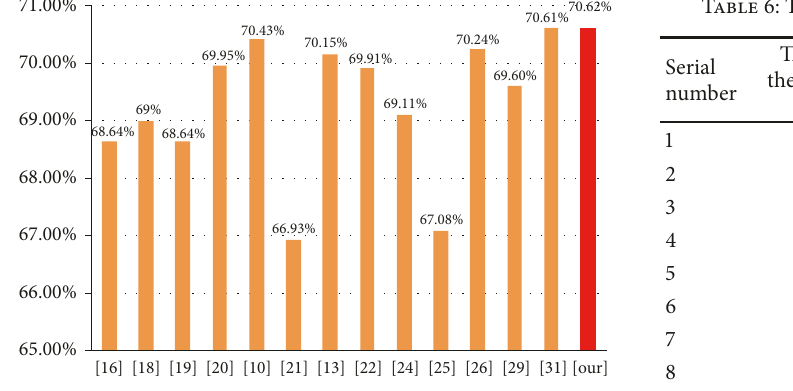
Figure 14: Bar chart of space utilization in weakly heterogeneous data test.